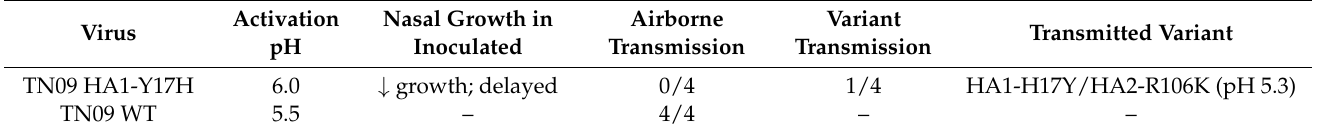
Table 4. A/Tennessee/1-560/2009 (H1N1) HA stability variants in ferrets